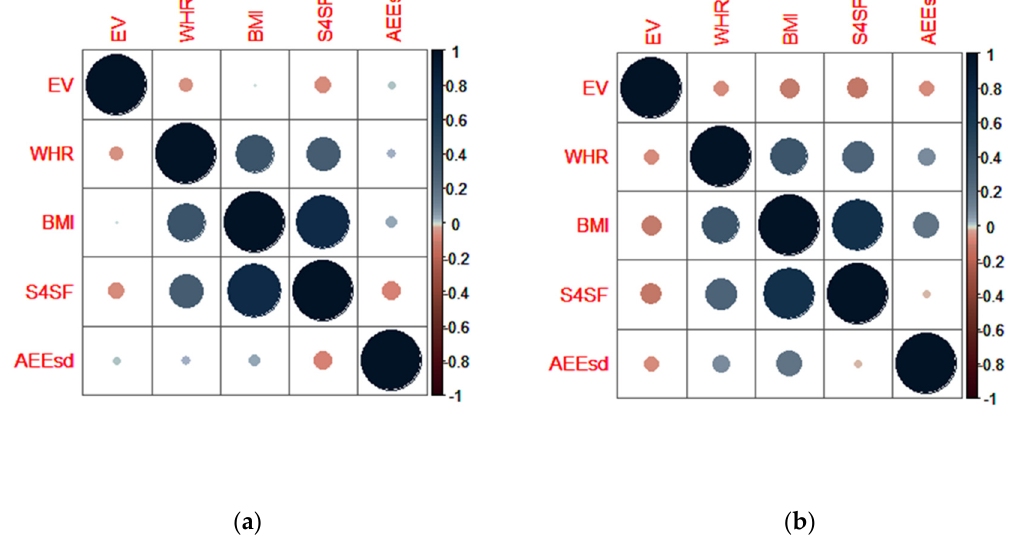
Figure 3. Spearman correlation matrix which shows the interplay between eveningness in energy intake (EV), anthropometric characteristics (WHR, BMI, and S4SF) and active energy expenditure during school days (AEE sd ) for the male population at the age of: ( a ) 15/16; ( b ) 18/19. As in males, a statistically significant correlation ( p < 0.01) among anthropometric variables was noted in the female population—both at the age of 15/16 and 18/19 (Figure 4). The only difference between the female and male population was found in 15/16-years old females showing statistically significant interplay ( p < 0.01) between EV and WHR (Figure 4a), while the same was not noted when females were 18/19-years old.